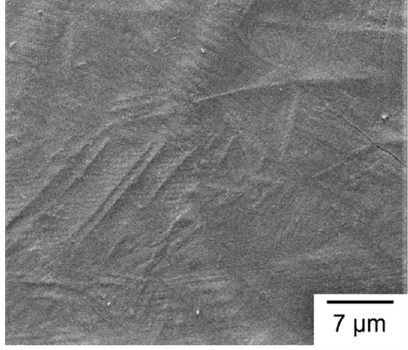
Figure 13. SEM micrograph of needle-like martensite laths at the top surface of as-built SLM 420 sample.